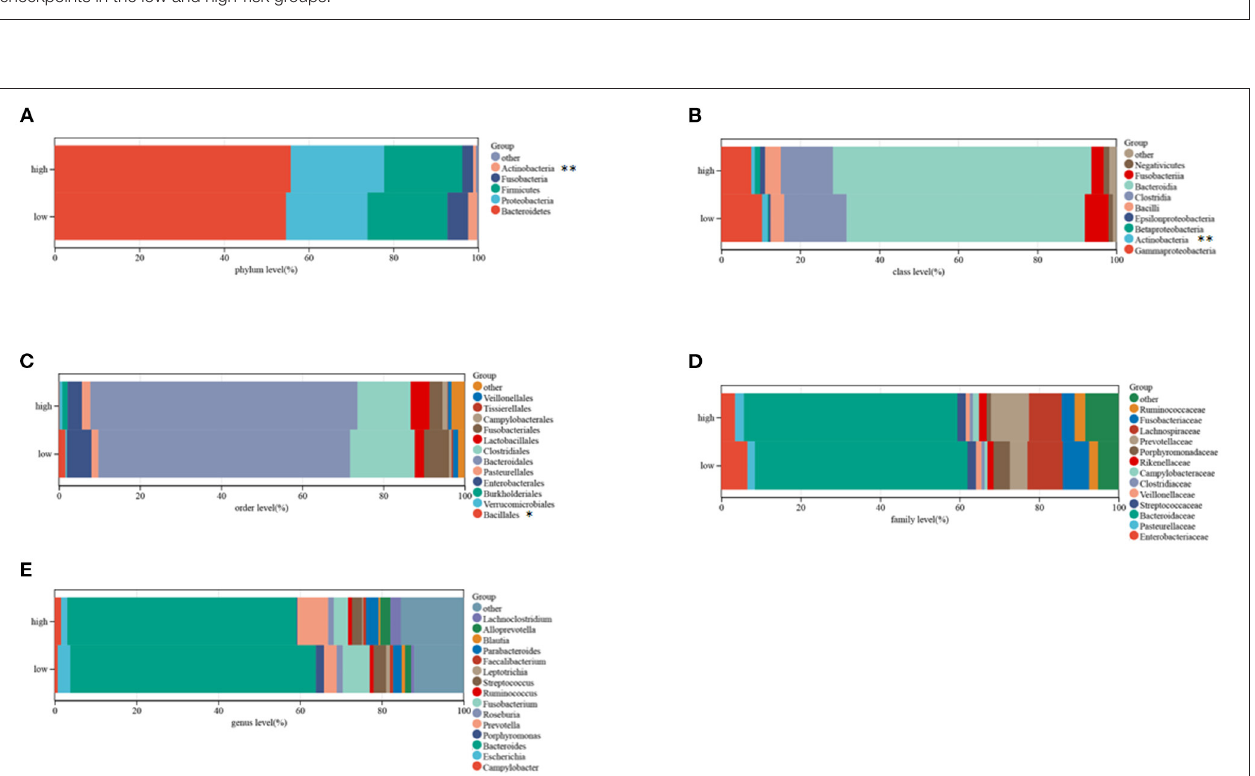
FIGURE 9 | Composition of microbiota in the low and high-risk groups at the phylum (A) , class (B) , order (C) , family (D) , and genus (E) levels, separately.